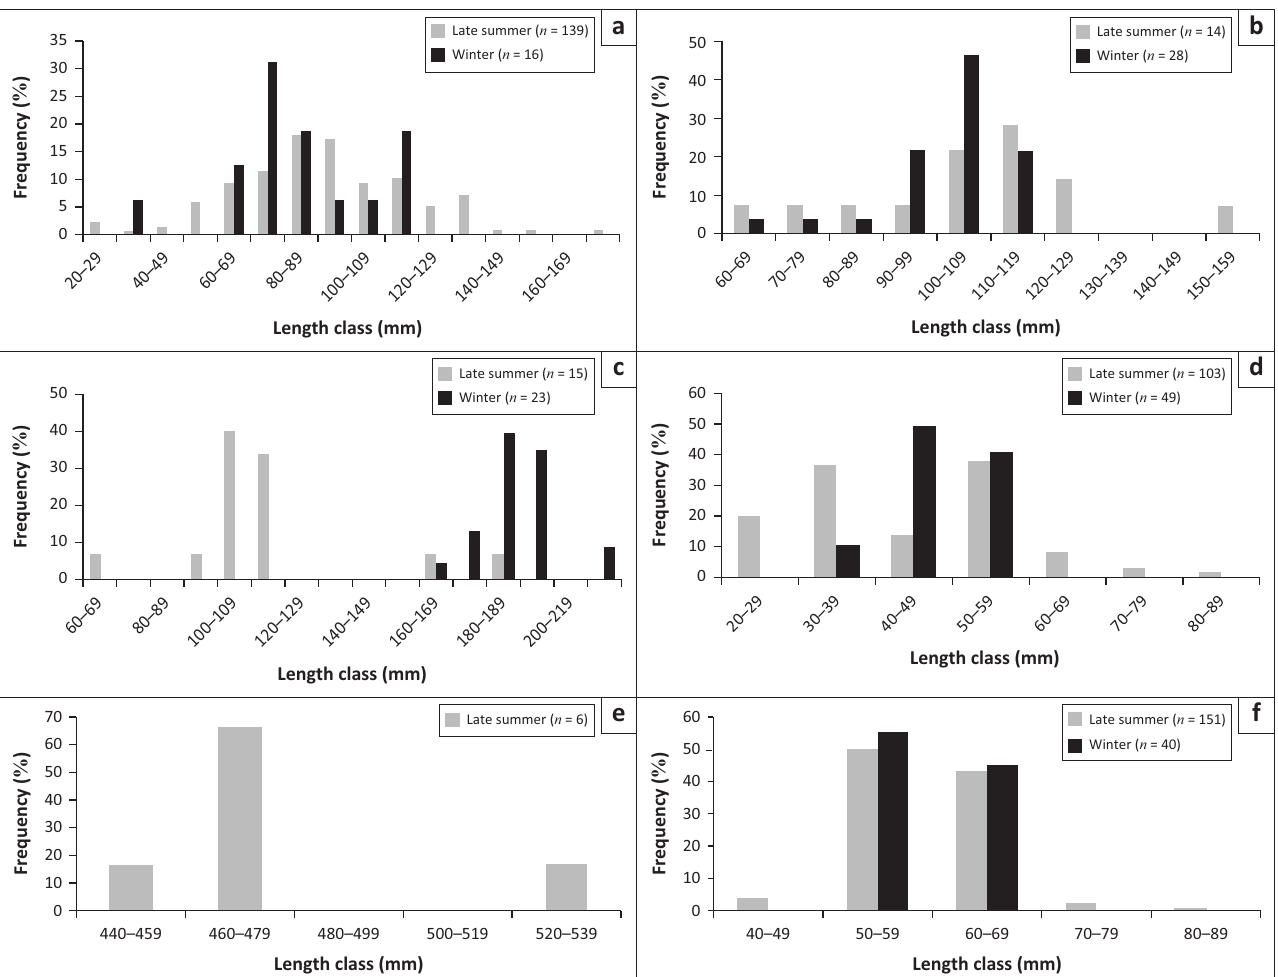
FIGURE 2: Length–frequency distribution of the more abundant species caught within the Noetsie Estuary. (a) Rhabdosargus holubi , (b) Monodactylus falciformis , (c) Lithognathus lithognathus , (d) Mugilidae , (e) Lichia aestuaria and (f) Gilchristella aestuaria